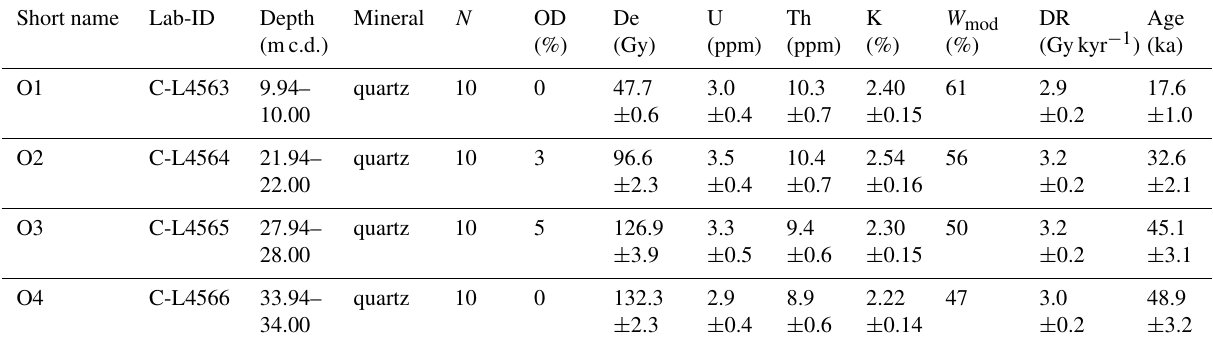
Table 1. Optically stimulated luminescence data and ages. Short names are used in the figures and discussion of this study. N – number of aliquots used for burial dose calculation; OD – over-dispersion; De – equivalent dose; W mod – measured water contents corrected for the effect of sediment compaction; DR – dose rate. Ages are provided with 1 σ